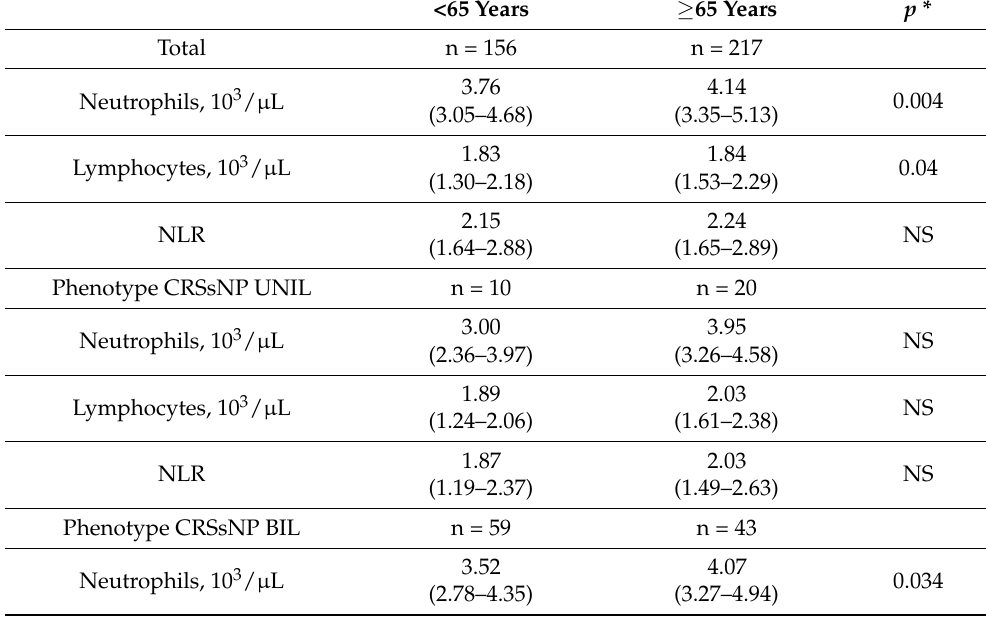
Figure 4. Neutrophils count in the group of patients <65 years of age for individual phenotypes.